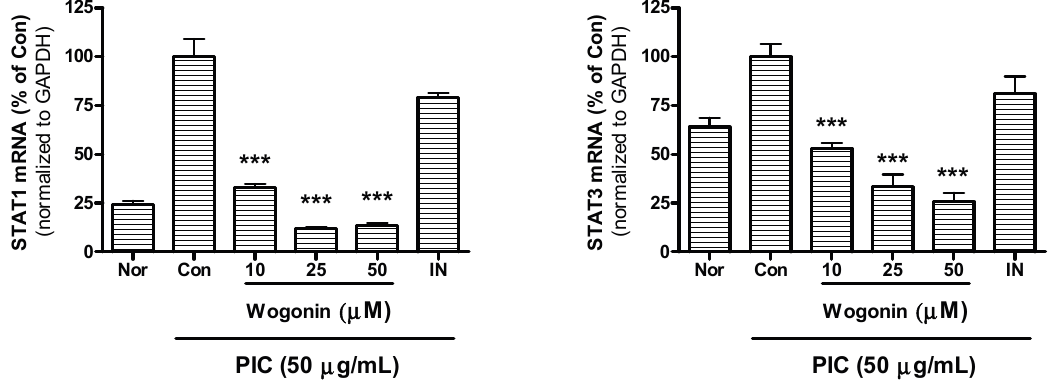
Figure 6. Effect of wogonin on mRNA expression of STAT1 and STAT3 in dsRNA-induced RAW 264.7 mouse macrophages. After 24 h treatment, the mRNA expression of STAT1 and STAT3 was measured by real time RT-PCR assay. STAT1 and STAT3 mRNA were normalized to the housekeeping gene GAPDH. Normal group (Nor) was treated with media only. Control group (Con) was treated with the synthetic analog of dsRNA (PIC, 50 µg/mL of polyinosinic-polycytidylic acid alone. IN denotes indomethacin (0.5 µM). Values are the mean ± SD of three independent experiments. *** P < 0.001 vs.